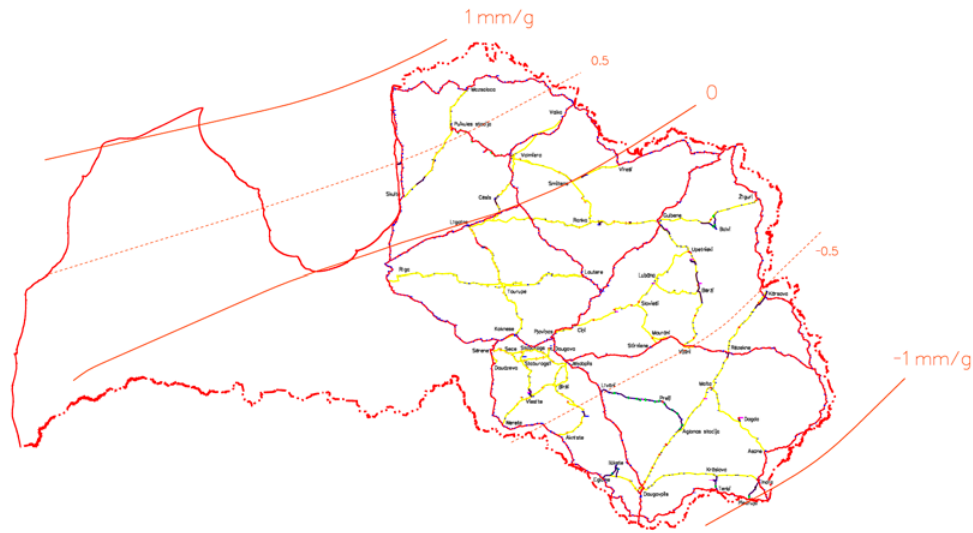
Fig. 2. LGIA formed Latvia Earth’s crust vertical movement model and adjusted part of 2 nd order network